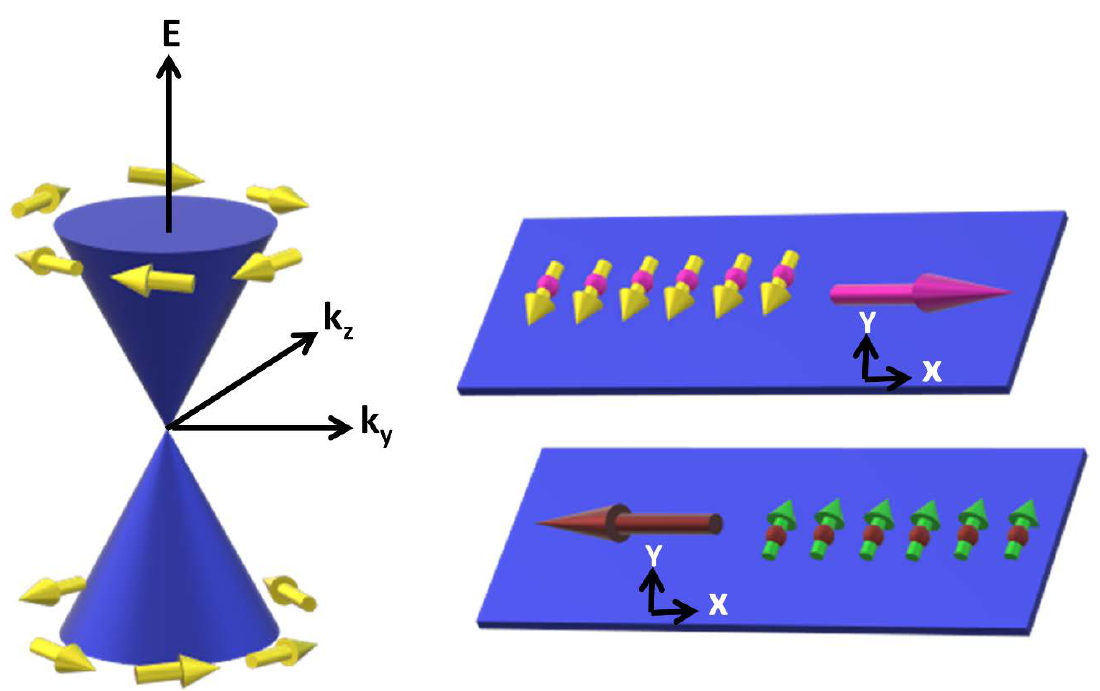
Figure 7. Orientation of spin along the direction.